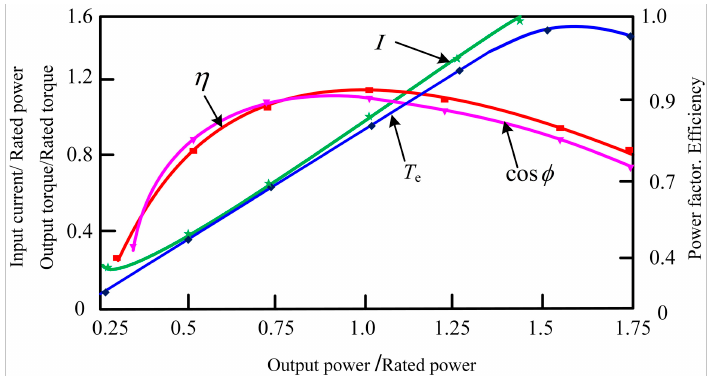
Figure 13. The simulated operating performance curves of the CR-PMSM.